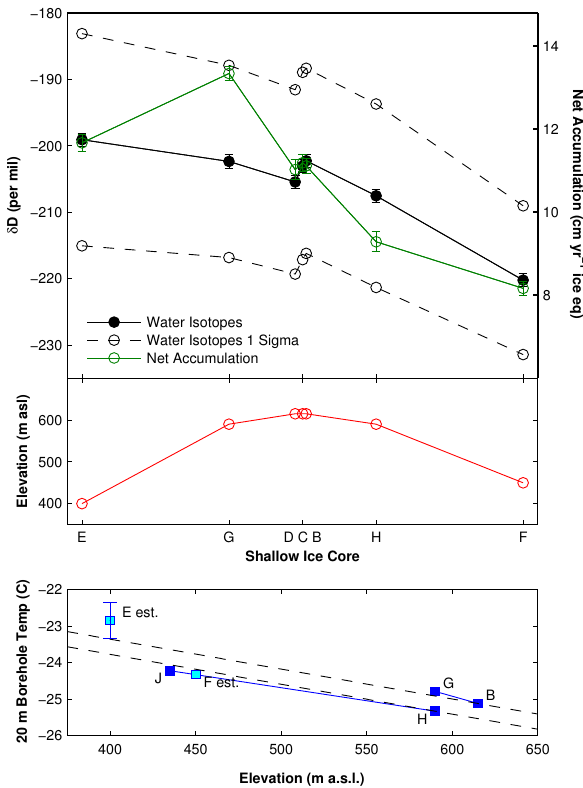
Figure 3. Top panel: shallow ice core mean δ D (solid black line, uncertainty bars attached), δ D standard deviation (black dashed Figure 3. Top) Shallow ice core mean δ D (solid black line, un- line), and mean net accumulation (solid green line, standard error certainty bars attached), δ D standard deviation (black dashed line), bars attached) on Siple Dome from 1920 to 1995. Middle panel: and mean net accumulation (solid green line, standard error bars at- the elevation profile of shallow ice cores at Siple Dome. Bottom tached) on Siple Dome from 1920-1995. Middle) The elevation pro- panel: shallow 20m borehole temperatures recorded at Siple Dome. file of shallow ice cores at Siple Dome. Bottom) Shallow 20 meter Dark blue squares denote temperature measurements. Blue lines borehole temperatures recorded at Siple Dome. Dark blue squares designate temperature trends. Dashed black lines designate adia- denote temperature measurements. Blue lines designate tempera- bats (0.82 ◦ C100m − 1 ). No borehole temperature was taken in the ture trends. Dashed black lines designate adiabats (0.82 o C / 100m). vicinity of core E (30km north) or core F (30km south). These tem- No borehole temperature was taken in the vicinity of Core E (30km perature values (light blue squares) are estimated using adiabats and north) or Core F (30km south). These temperature values (light blue temperature squares) are estimated using adiabats and temperature trends.